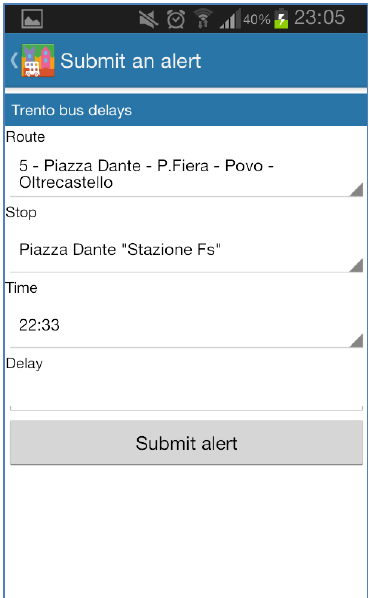
Figure 6. Form for broadcasting delay notifications